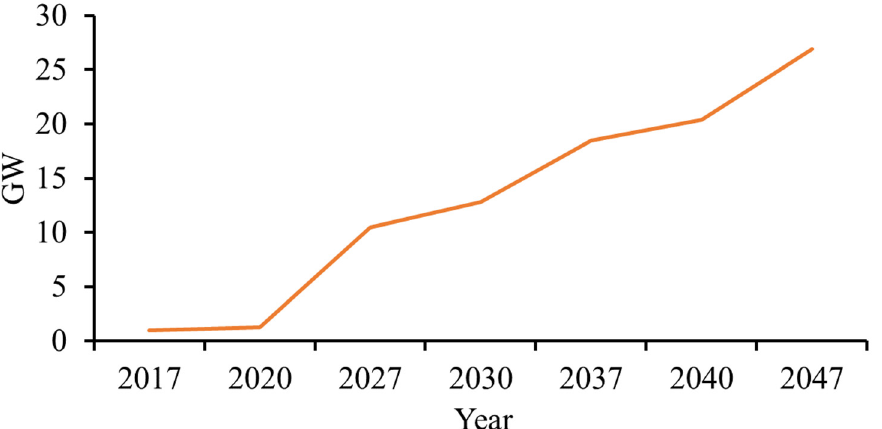
Figure 6. The trend of the PV capacity in Pakistan till 2047 [13].